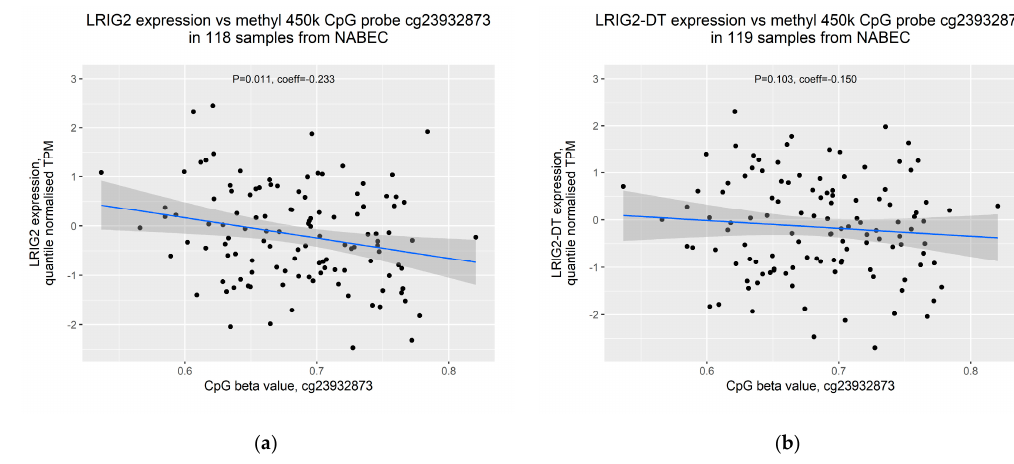
Figure 6. Expression of transcripts from the LRIG2 locus versus CpG 450K methylation data for probe cg23932873 in frontal cortex of 129 NABEC individuals. ( a ) LRIG2 (ENSG00000198799.12). ( b ) LRIG2-DT (ENSG00000238198.2). Blue line indicates trend line; dark grey zone indicates 95% confidence interval. Pearson correlation coefficient and corresponding p values displayed.